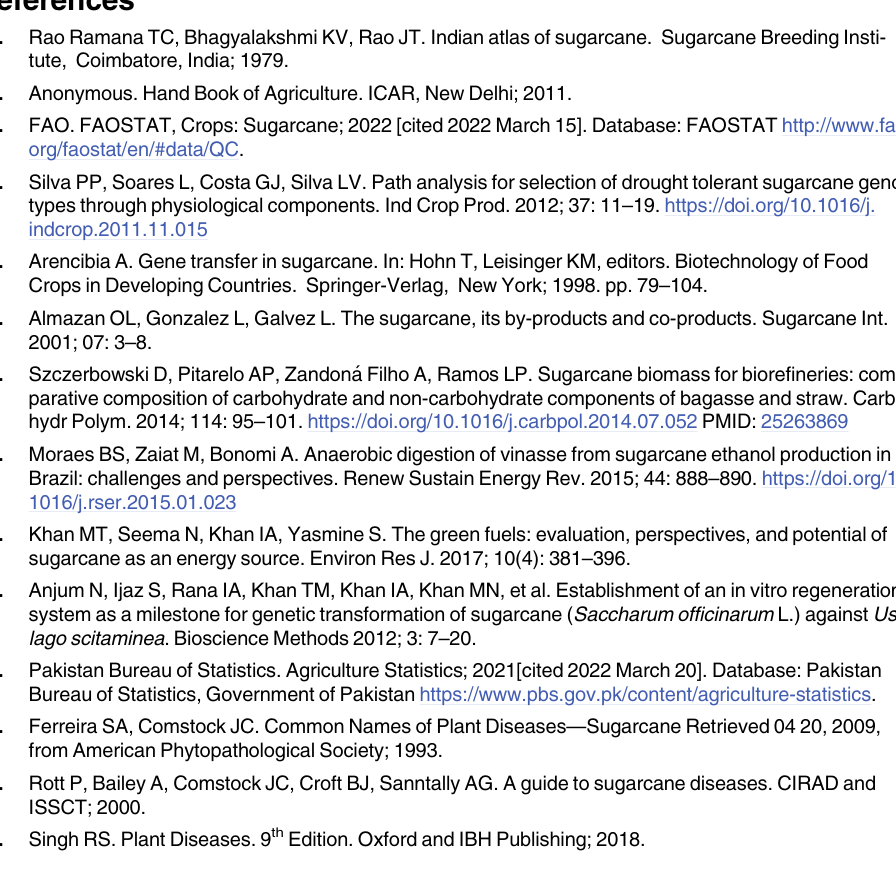
S5 Table. Effects of whip smut Sporisorium scitamineum on CCS percentage of sugarcane varieties/cultivars in field screening trial with artificial